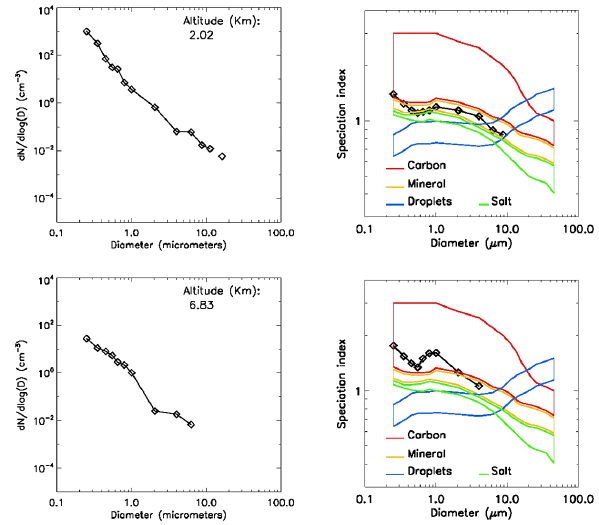
Figure 16. Examples of size distributions and typology at two al- titudes for the 18 June 2013 flight from Minorca (Spain); the un- certainties for concentrations are the same as in Fig. 15; the sizes of the dots represent the error bars for the typology. At an altitude of ∼ 2km the typology indicates mineral particles; at ∼ 7km, the typology indicates carbonaceous particles for the smallest size.